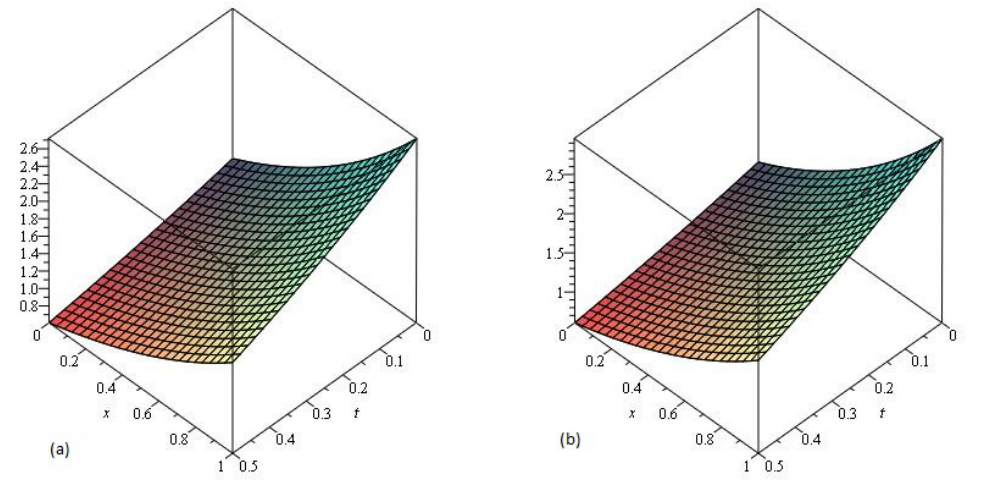
Figure 4. The ( a ) LADM solutions of υ ( x , t ) of Example 2 at γ = 1 and ( b ) γ =